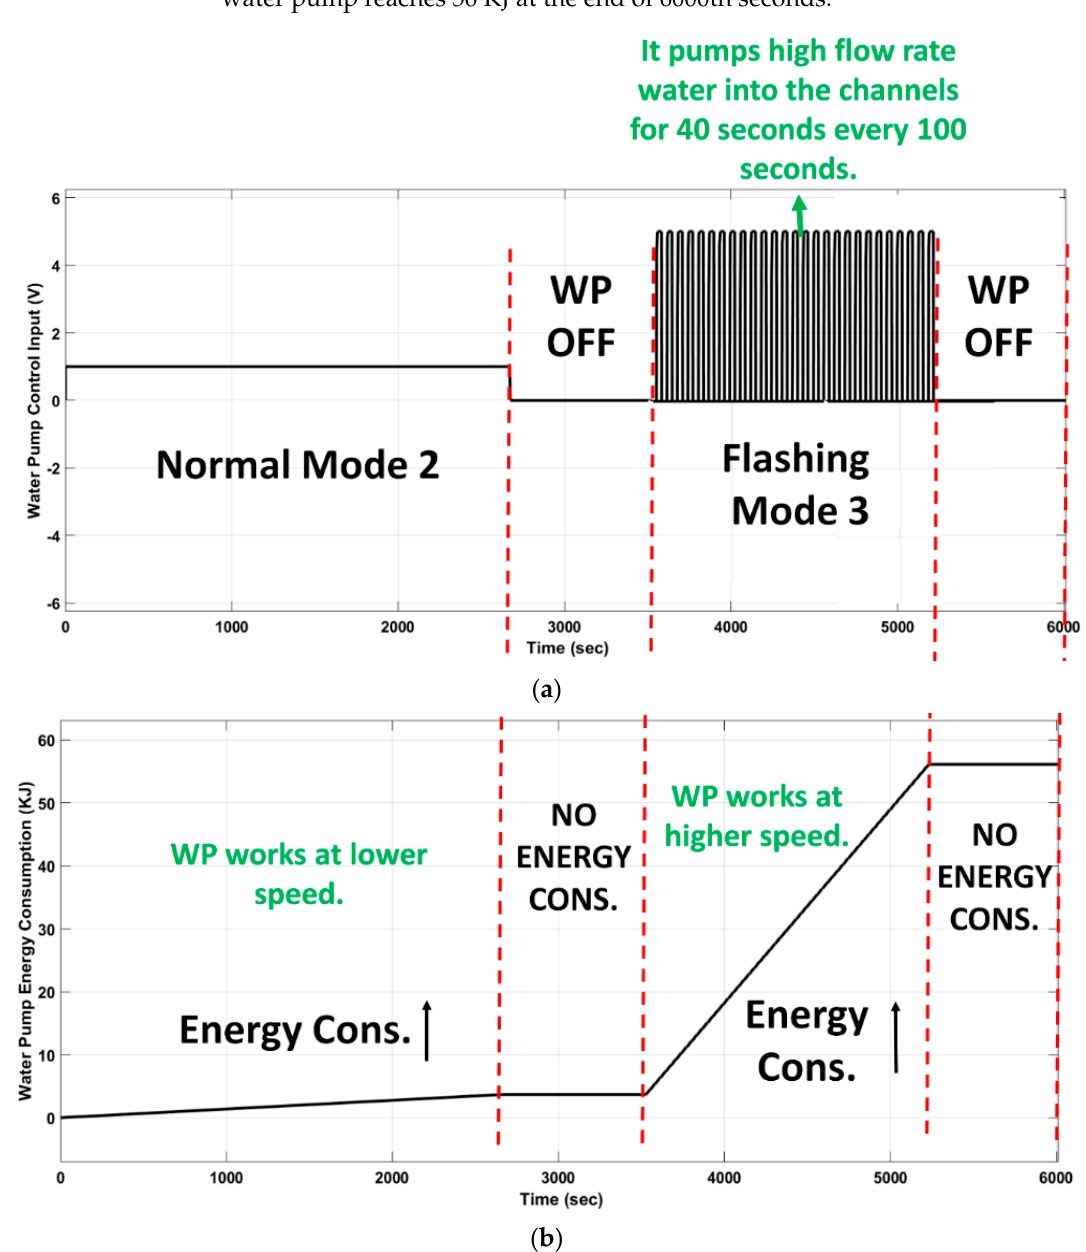
Figure 8. ( a ) The control input for the water pump. ( b ) The energy consumption of the water pump. The control input applied to the water pump by the controller and the energy con-